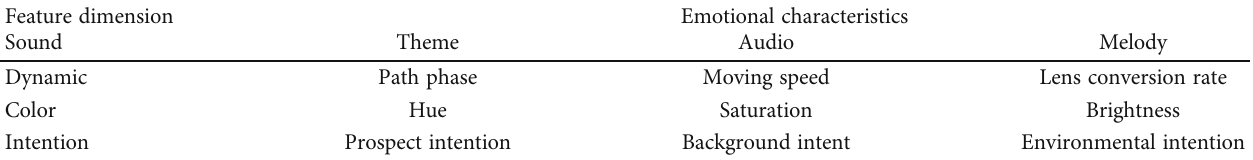
Table 2: List of multidimensional emotional